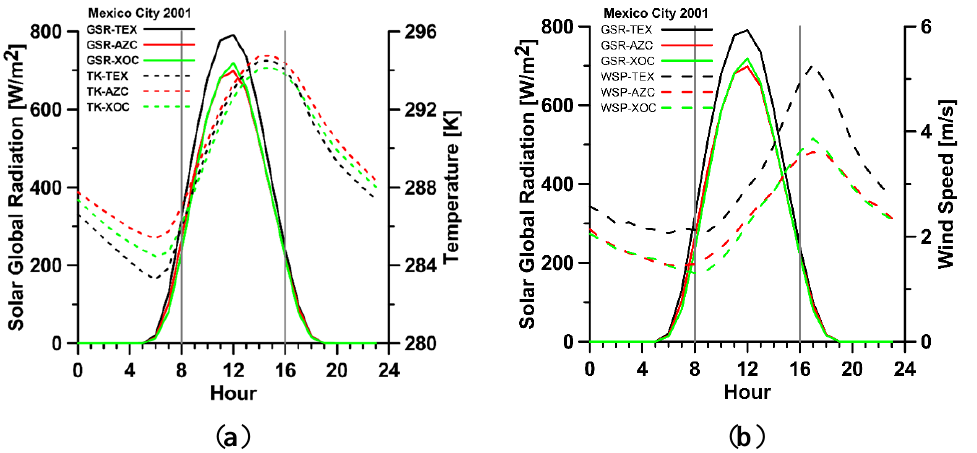
Figure 7. Annual averages of the hourly trends of global solar radiation (GSR), temperature (TK), and wind speed (WSP) measured in Mexico City at the stations Texcoco (TEX), Azcapotzalco (AZC) and Xochimilco (XOC) during the IIE2001 campaign